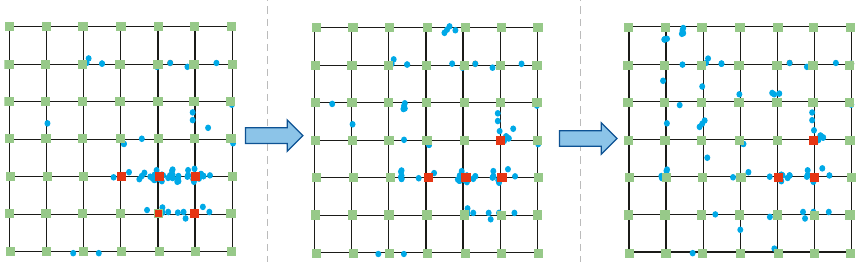
Figure 2: The evacuation process of crowded passengers under the release of VMS information in road